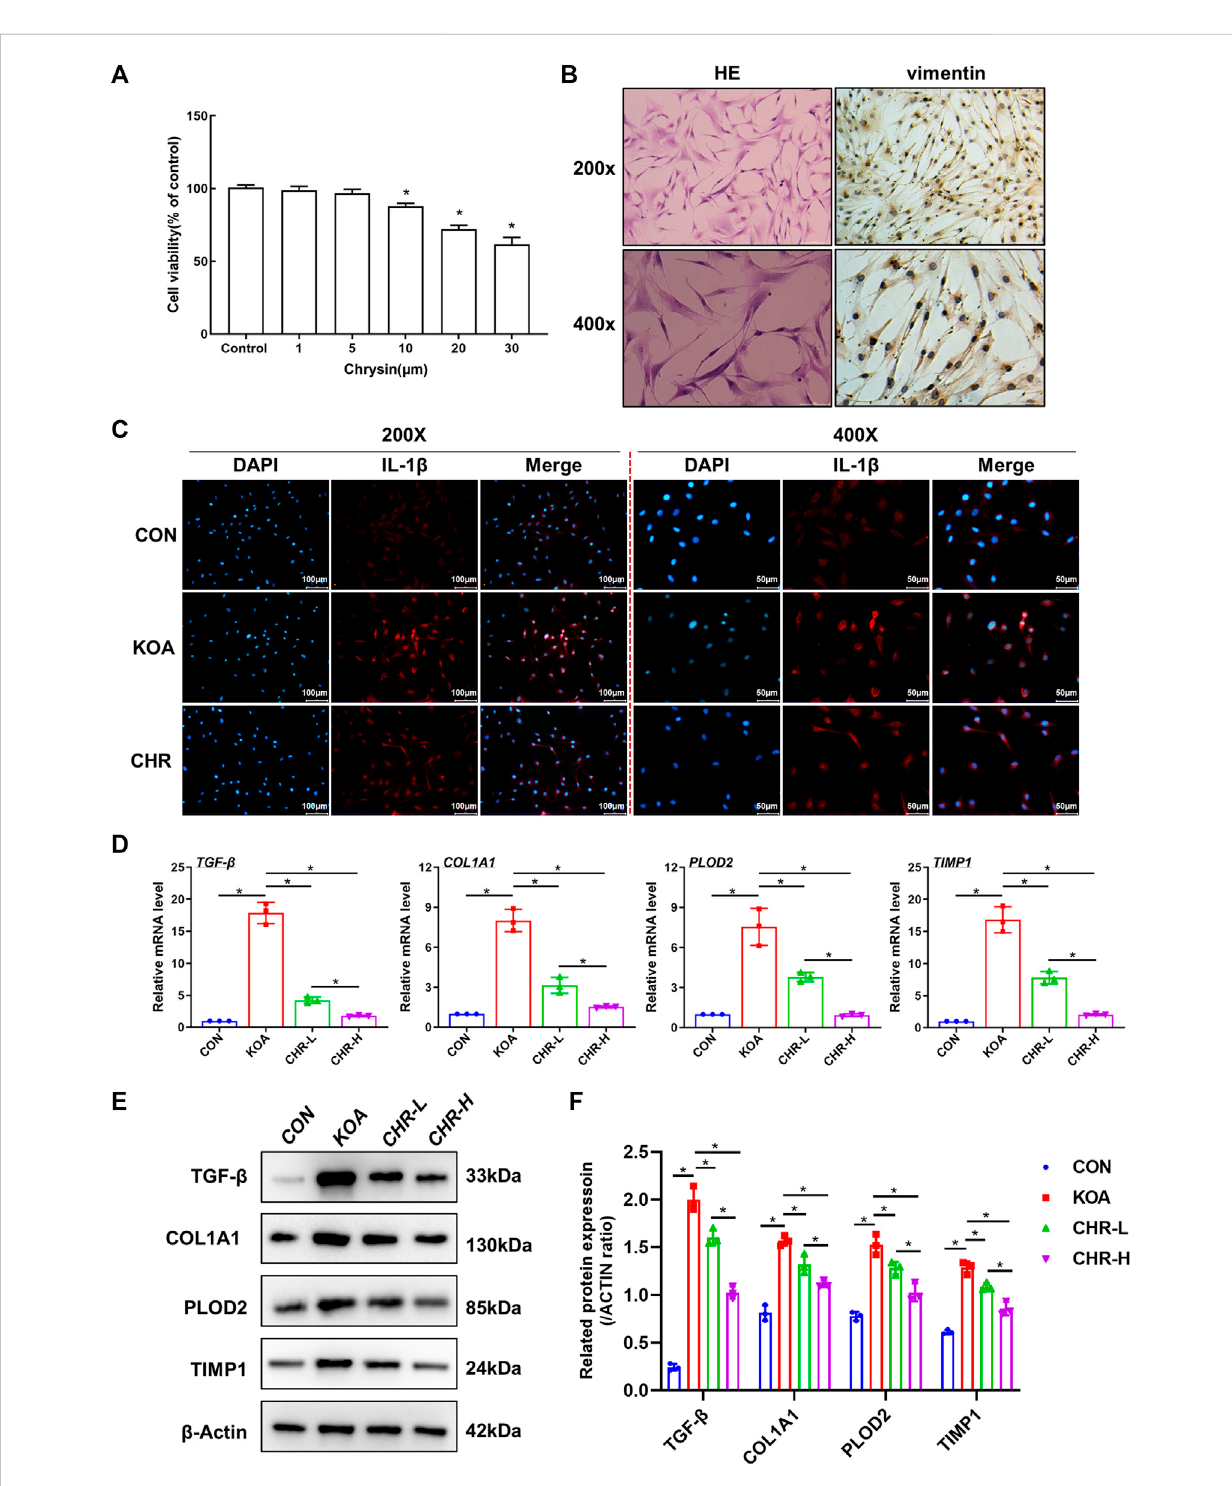
CHRamelioratesTGF- β -inducedsynovialin fl ammationand fi brosisinSFs. (A) HEandanti-vimentinimmunostainingofSFsforcellidenti fi cation. (B) The viability of SFs in response to CHR (1, 5, 10, 20, and 30 μ M). (C) Representative images showing immuno fl uorescence analysis of IL-1 β in the sham, KOA, and CHR groups at 200× or ×400 magni fi cation. n = 3. Scale bars: 100 μ m or 50 μ m. (D) Real-time PCR analysis of TGF- β , COL1A1, PLOD2, and TIMP1. (E) Immunoblot analysis of TGF- β , COL1A1, PLOD2, and TIMP1. (F) Protein levels of TGF- β , COL1A1, PLOD2, and TIMP1 in the groups. n = 3 per group. The data in this fi gure are presented as the mean ± standard deviation, and statistical signi fi cance was determined with one-way ANOVA followed by Tukey ’ s post hoc analysis. p p <